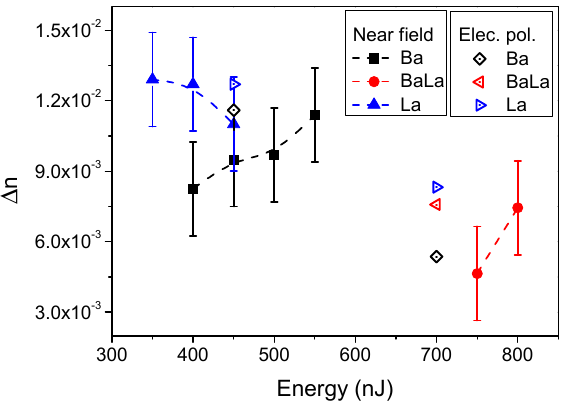
Figure 4. Refractive index contrast at the guiding region estimated from the measured MFD of the single mode waveguides produced in the three glass compositions indicated (Ba-, La- and Ba-La-glass) (solid symbols). The open symbols correspond to the index contrast estimated using experimental EDX local compositional measurements and the electronic polarizability method, as described in the text.